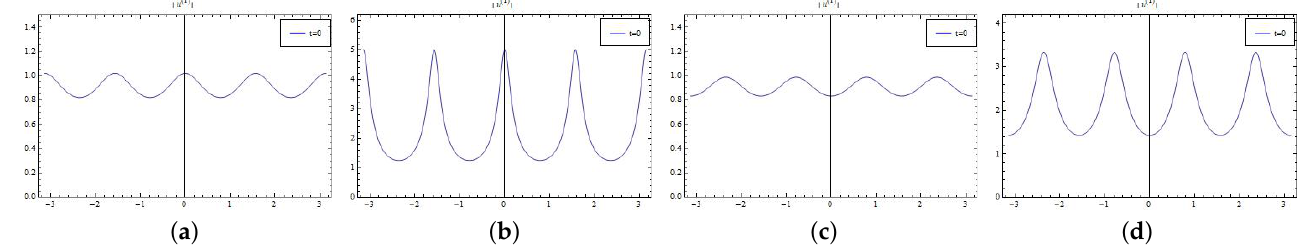
Figure 1. Double periodic wave solution | u ( 1 ) | for the nonlocal gSS equation with b = 1